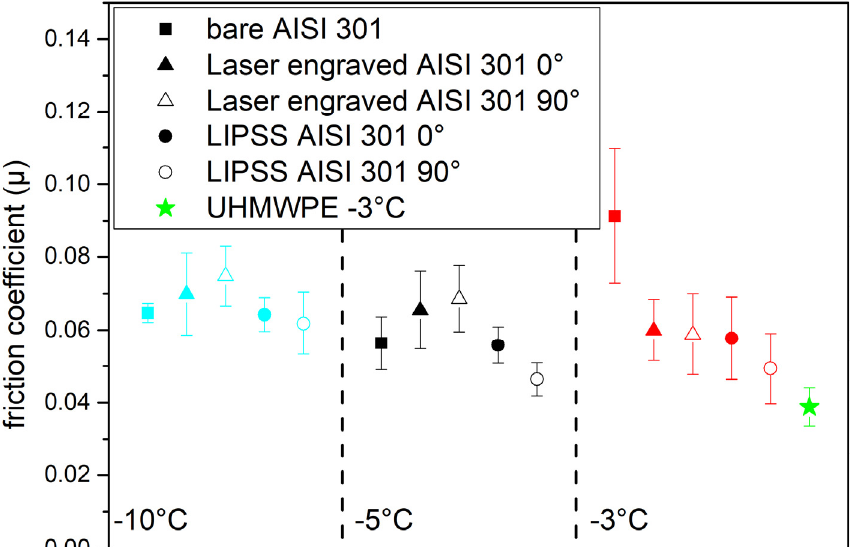
Figure 7. Average µ values of differently treated AISI 301H samples, at different temperatures and for parallel (full symbols) and perpendicular (open symbols) gliding on snow. For reference the green star is the average µ value for parallel gliding at − 3 °C of stone grinded and waxed UHMWPE.